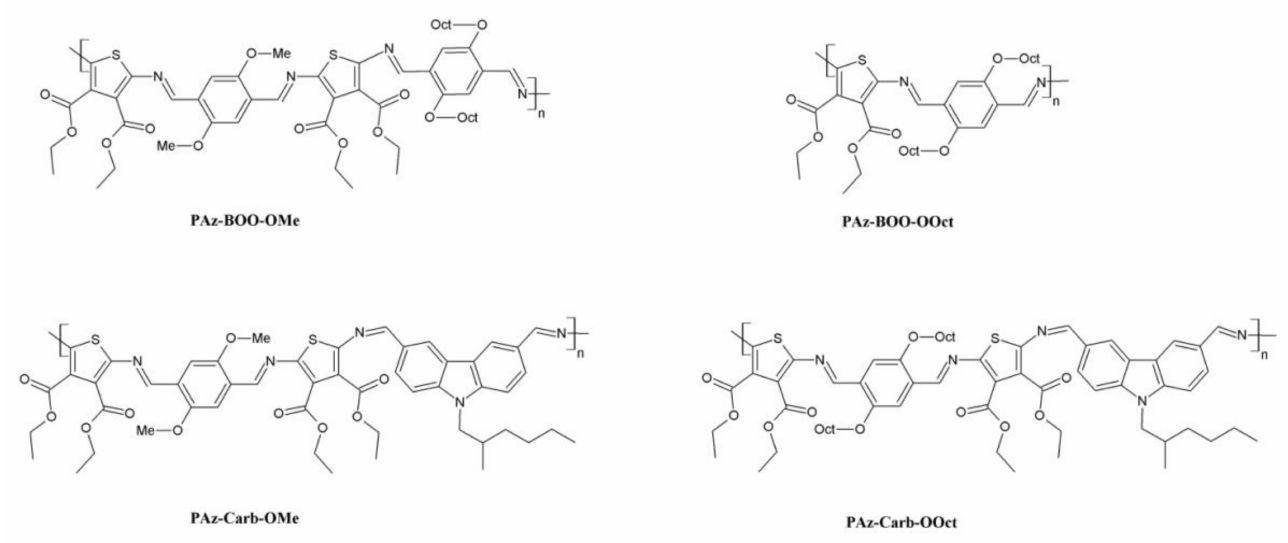
Figure 2. Chemical structures of synthesized compounds, together with polyazomethine obtained during previous studies ( PAz-BOO-Oct )